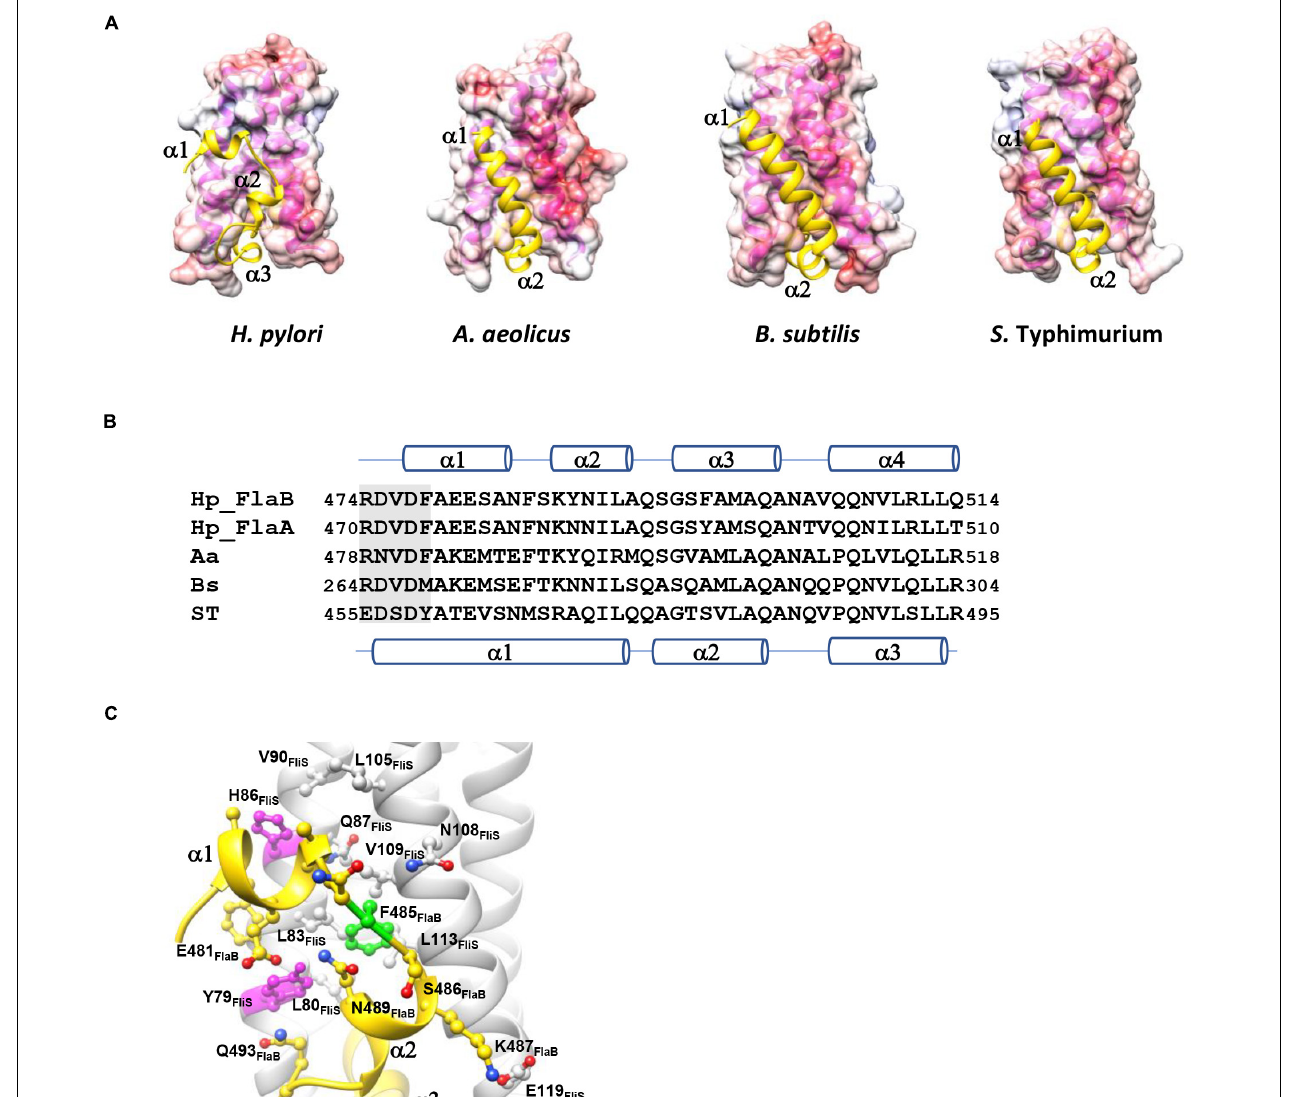
FIGURE 3 | Comparison of the FliS-flagellin binding interfaces in different bacterial species. (A) The molecular surface of FliS is colored according to the electrostatic potential, with a contour level of ± 10 kT. FlaB C /FliC are represented by cartoons and colored in yellow. FliS-FliC models of A. aeolicus , S. Typhimurium and B. subtilis were retrieved from PDB ID (1ORY, 6CH3, and 6GOW, respectively). Only the D0 domains of FlaB/FliC are shown. (B) Sequence alignment of the spoke region (shaded) and D0 domain in the C-terminal end of flagellin. The secondary structures of FlaB of H. pylori and of FliC of S. Typhimurium are indicated above and below the sequence, respectively. (C) The variable residues Tyr79 and His86 (magenta) shape the FlaB binding groove on FliS. Phe485 of FlaB is buried in the hydrophobic pocket of FliS (highlighted in green).